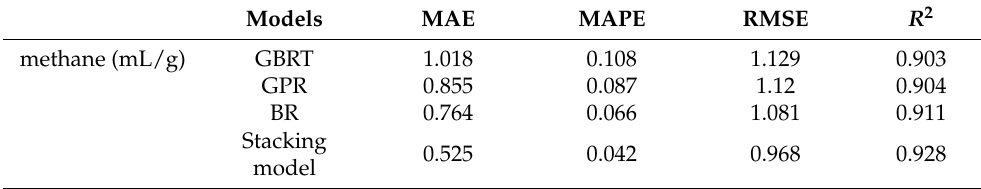
Table 2. Comparison of the methane prediction performances of different models.